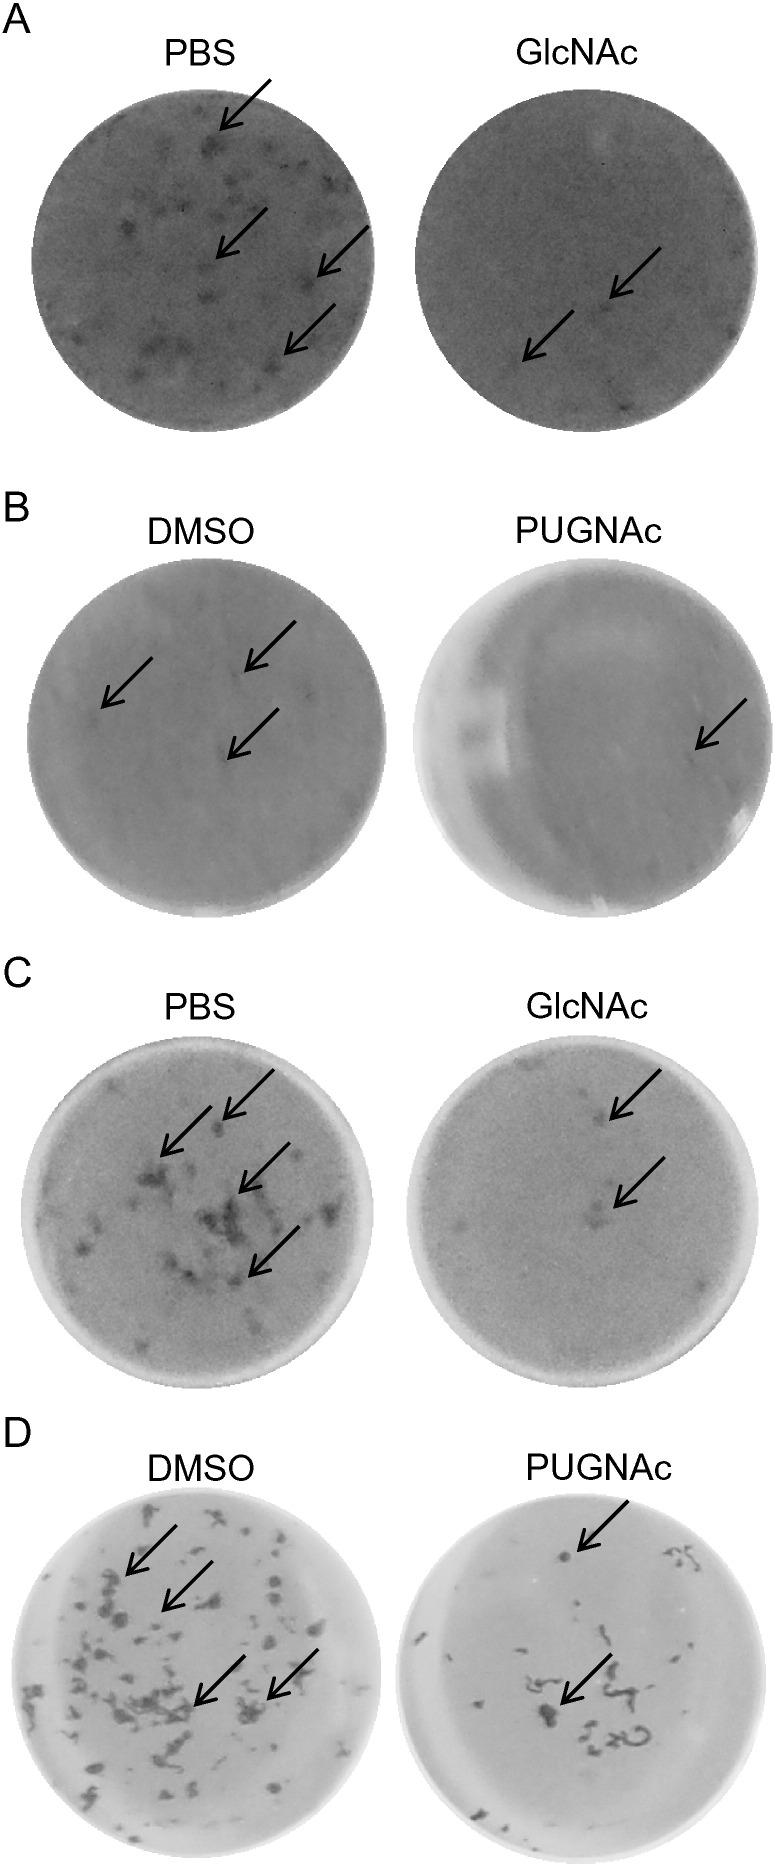
Resorption pits generated by RAW264 cells and PBMCs.(A and B) Representative images of resorption pits generated by RAW264 cells treated with RANKL and either GlcNAc (A) or PUGNAc (B). These images correspond to the data presented in Fig. 3D. (C and D) Representative photos of resorption pits generated by PBMCs treated with RANKL, M-CSF, and either GlcNAc (C) or PUGNAc (D). These images correspond to the data presented in Fig. 4B. Some, but not all, generated pits are indicated by arrows.